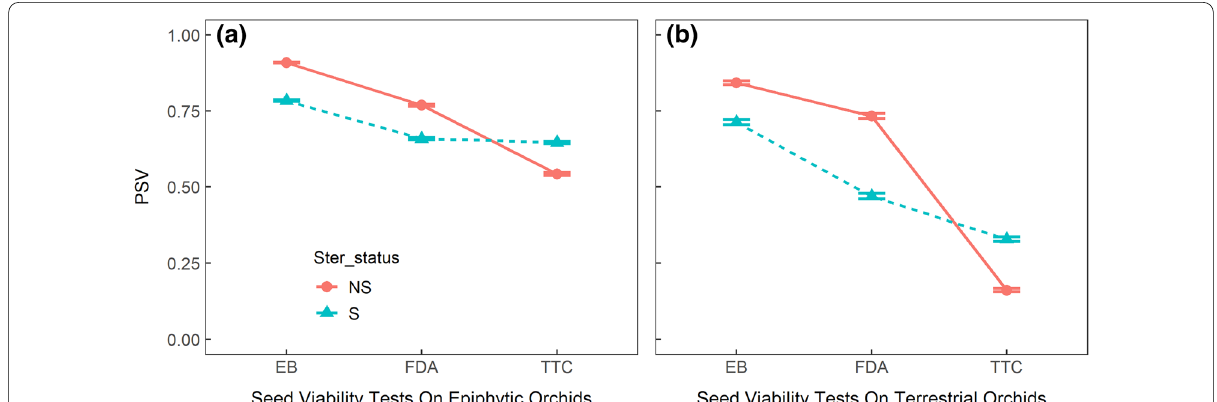
Fig. 2 The probability of finding viable seeds (PSV) after subjecting to three seed viability tests; Evans blue test (EB), Fluorescein diacetate test (FDA) and Tetrazolium test (TTC) for ( a ) epiphytic and ( b ) terrestrial orchids, without sterilization (NS) and with sterilization (S) of seeds